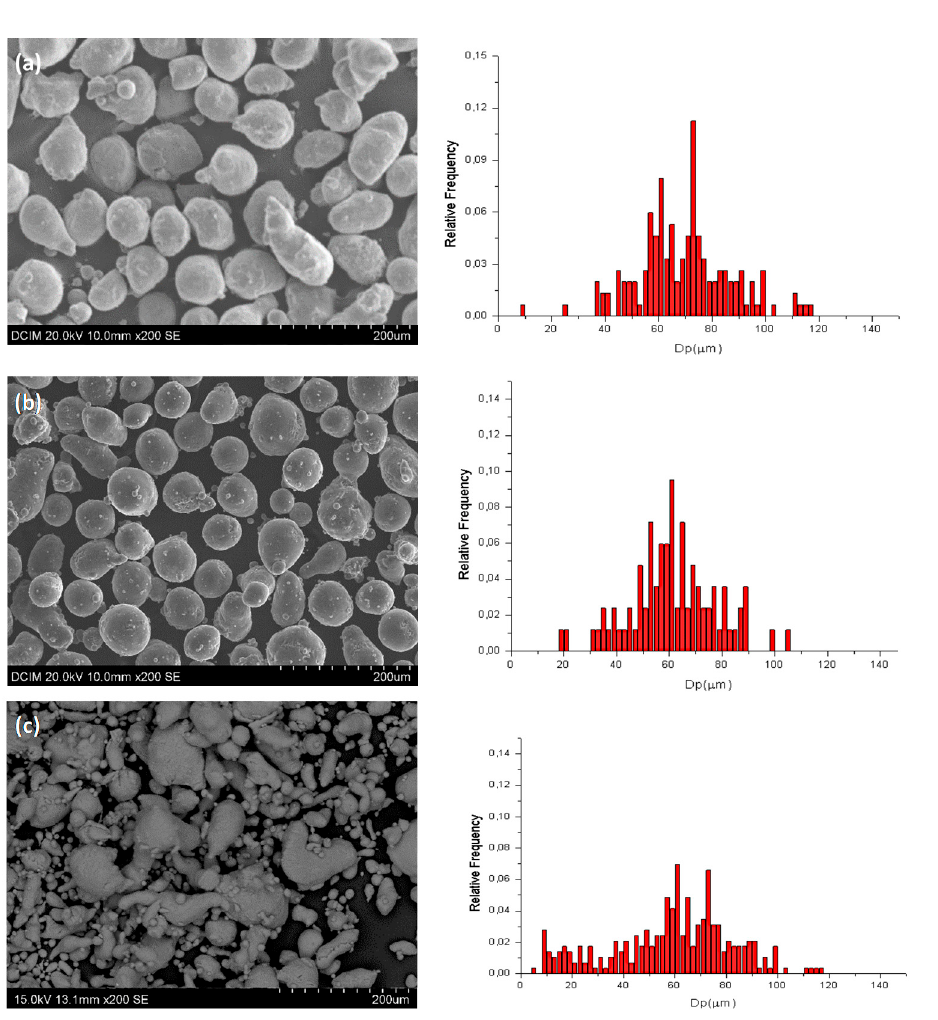
Figure 1. ( a ) Al particles as-received, ( b ) Al-12Si particle as-received, ( c ) AA6061